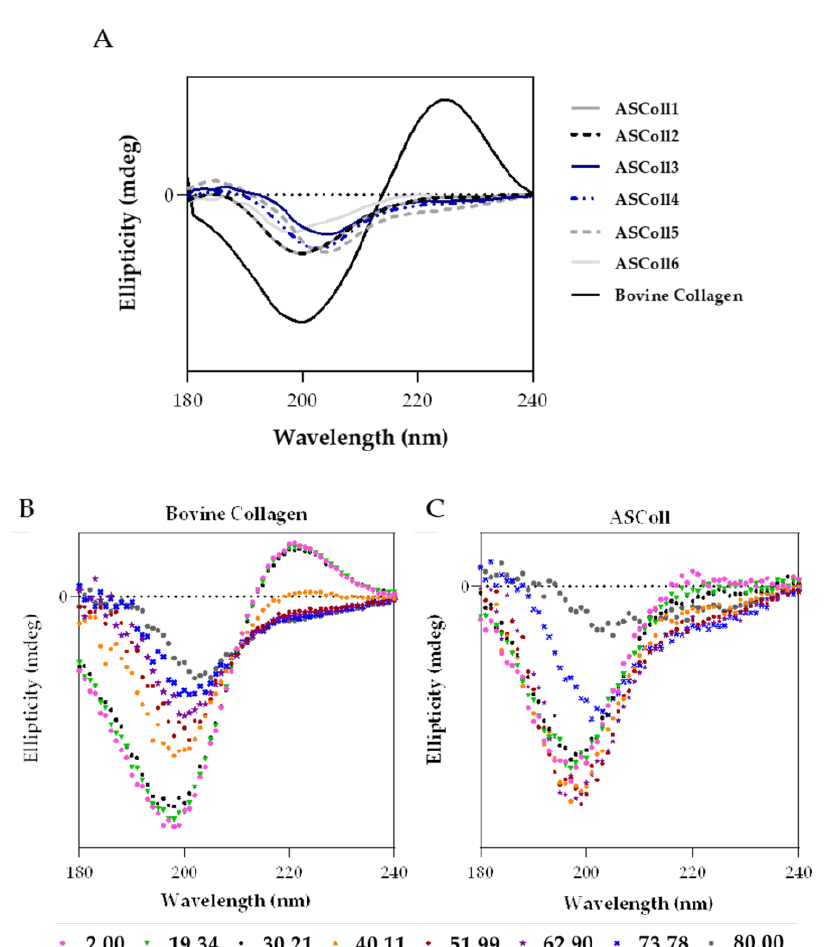
Figure 4. Circular dichroism (CD) analysis of ASColl. ( A )—CD spectra of the ASColl and the commercial type I collagen from bovine skin, acquired at 25 °C. ( B )—CD spectra of the commercial type I collagen from bovine skin, recorded as a function of temperature, between 2 °C and 80 °C. ( C )—CD spectrum of the ASColl, recorded as a function of temperature, between 2 °C and 80 °C.